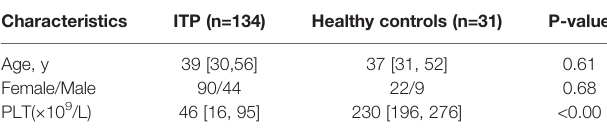
TABLE 2 | Demographic and characteristics for CXCL13 measurement in ITP cohort and healthy controls.